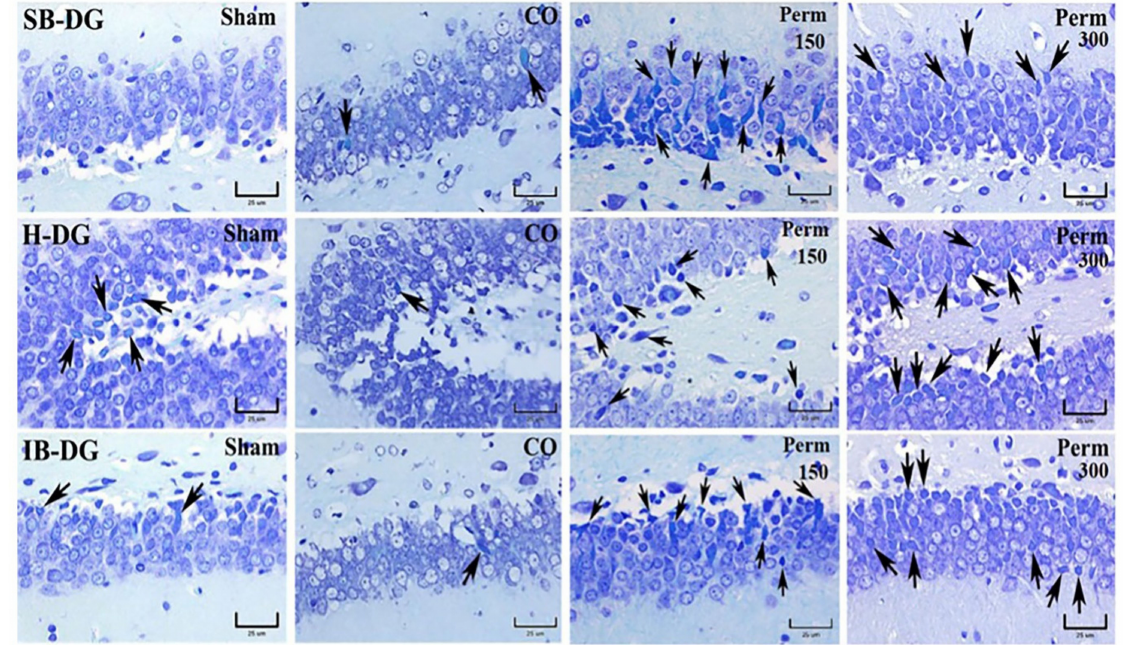
Figure 6. Photomicrographs of the superior lamina (SB-DG), hinge region (H-DG) and the inferior lamina (IB-DG) of the hippocampal dentate gyrus of rats with or without treatment. Arrows indicate neurons with histopathological features of cell degeneration or death by Klüver-Barrera